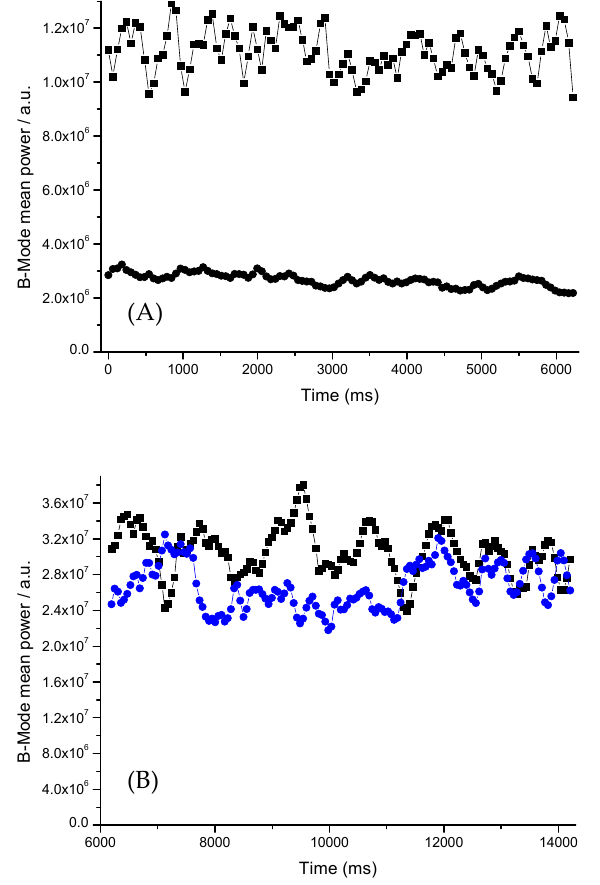
Figure 7. Contrast in the ultrasound B-Mode as function of time. ( A ) PFH base emulsions with 0.5% ( ■ ) and 1% ( ● ) of Zonyl ® at room temperature. ( B ) 0.5% Zonyl ® PFH ( ■ ) and PFP ( ● ) based emulsions at 37 °C.